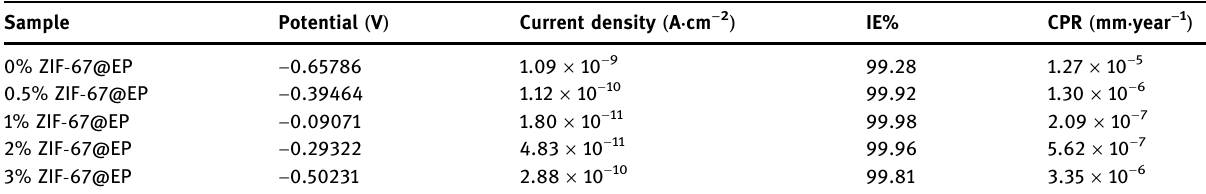
Table 1: Polarization parameters of the coating in 3.5% NaCl ( aq )